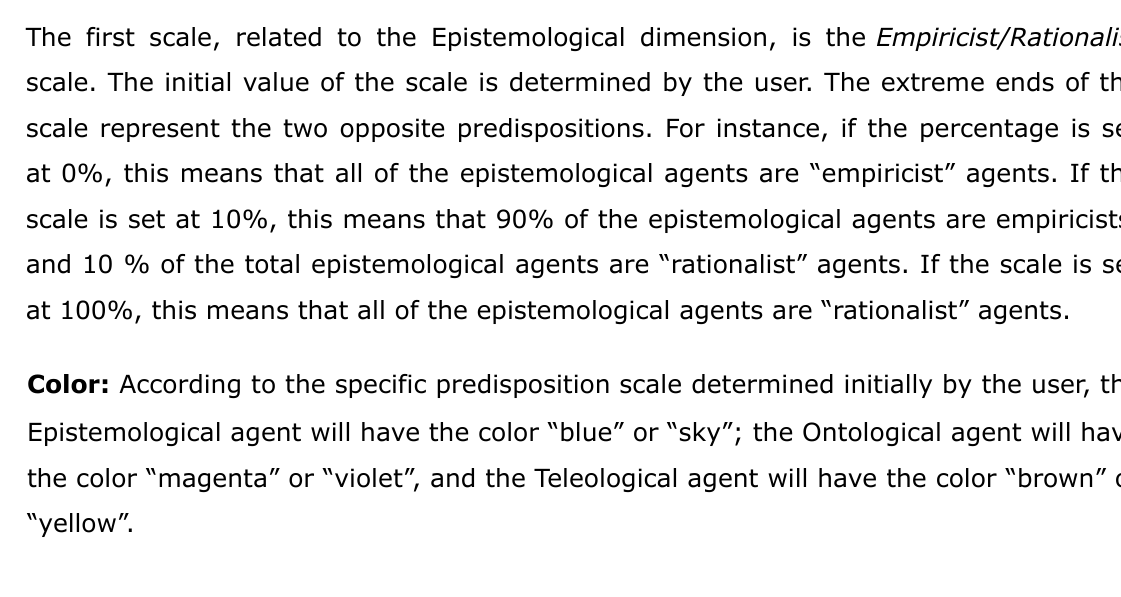
the color “magenta” or “violet”, and the Teleological agent will have the color “brown” or “yellow”.